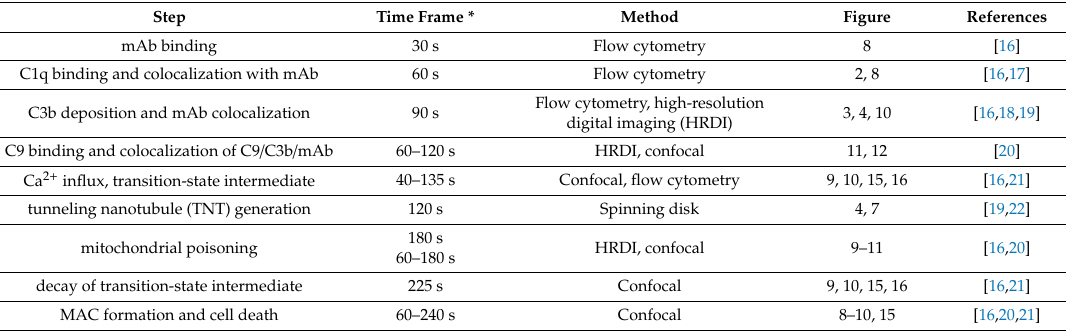
Table 1. Observed consecutive steps in monoclonal antibody (mAb)-mediated complement-dependent cytotoxicity